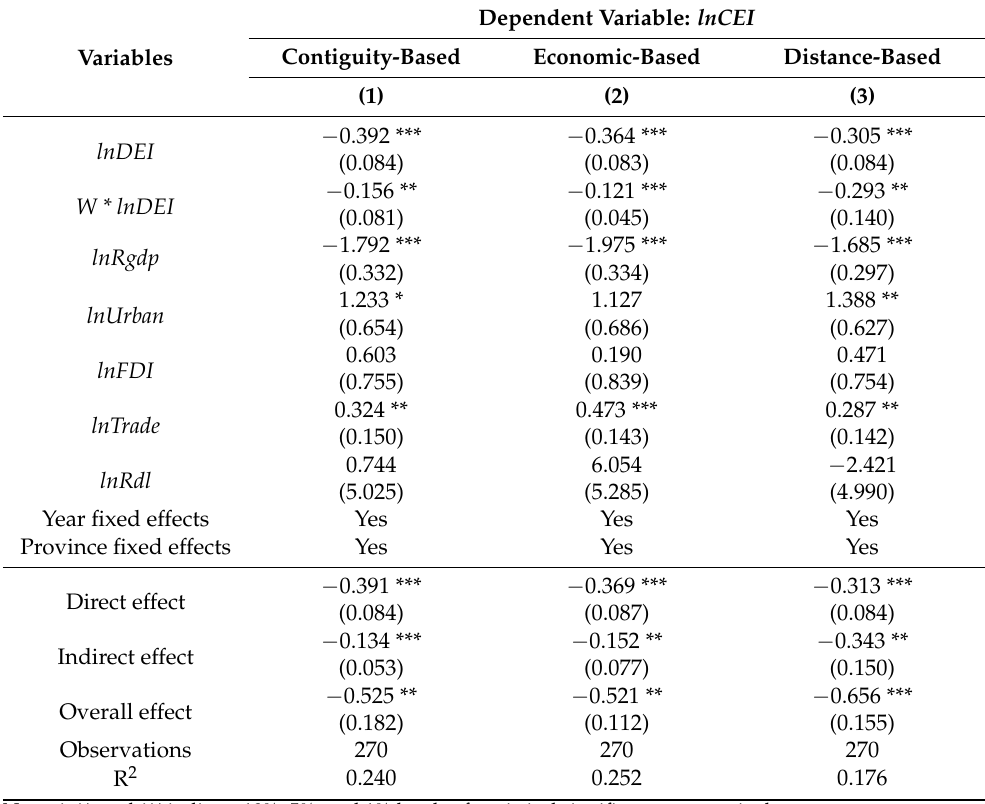
Table 10. The spatial regression results under three spatial weighted